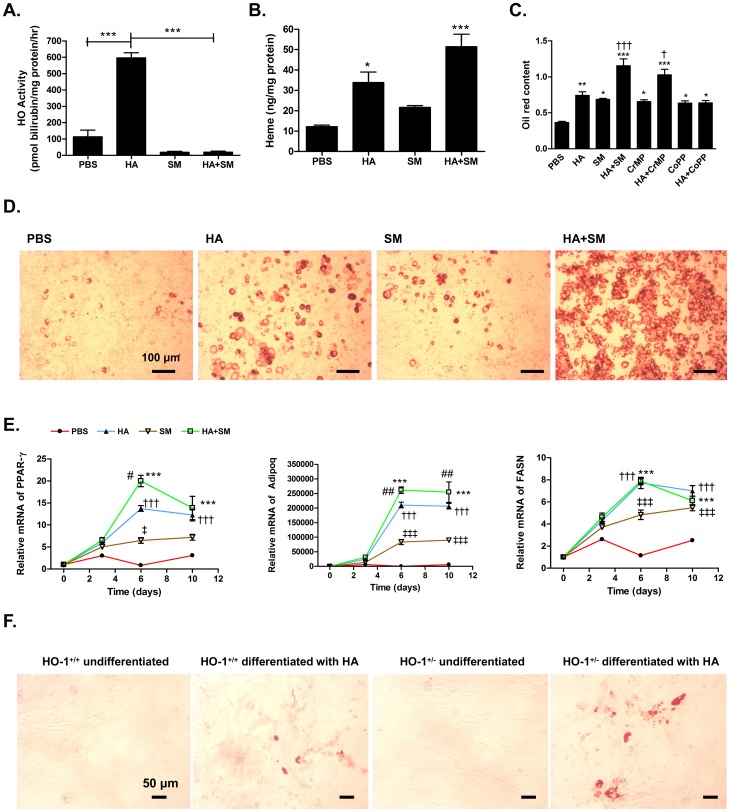
Concomitant administration of SM accentuates adipogenic potential of HA in vitro.
A. HO activity, B. Heme concentrations, C. Quantification of Oil Red staining and D. Representative light microscopic (x100) image of Oil Red uptake in differentiated adipocytes following 10 days treatment of 3T3 cells with an adipogenic differentiation cocktail alone or with the addition of protoporphyrins. B, C: *P<0.05, **P<0.01, ***P<0.001 v PBS; †P<0.05, ††P<0.01 v HA. E. Time course changes in gene expression of adipogenic genes including PPAR-γ, Adipoq, FASN in 3T3-L1 cells treated with an adipogenic differentiation cocktail alone or with the addition of 20 µM HA, 20 µM SM or HA+SM. †††P<0.001: HA v PBS; ‡P<0.05, ‡‡‡P<0.001: SM v PBS, ***P<0.001: HA+SM v PBS; #P<0.05, ##P<0.01: HA+SM v HA. P-values derived by 2-way ANOVA with Bonferroni’s multiple comparison post-test. The data are mean ± s.e.m from n = 4/group. F. Representative (200x) images of Oil Red staining of stromal vascular fraction cells from epididymal fat pads of HO-1+/+ (left) and HO-1+/− (right) mice either undifferentiated or following differentiation by an adipogenic cocktail in the presence of HA.